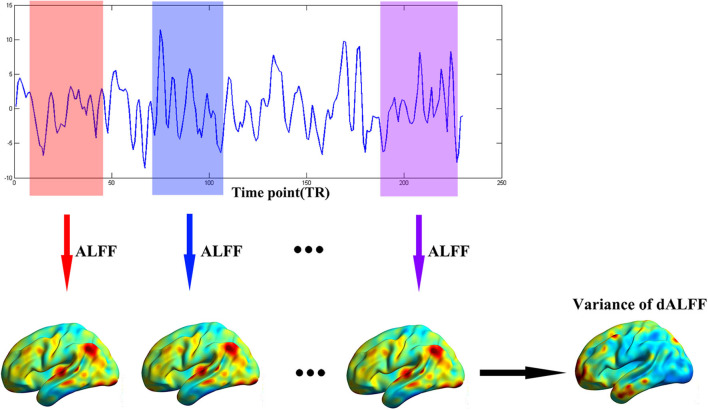
The flow chart of our method. The full-length BOLD fMRI series was segmented into numbers of sliding windows which was represented in different colors. For each sliding window, the ALFF was calculated for each voxel. Last, the variance of dALFF maps across the sliding windows was computed.